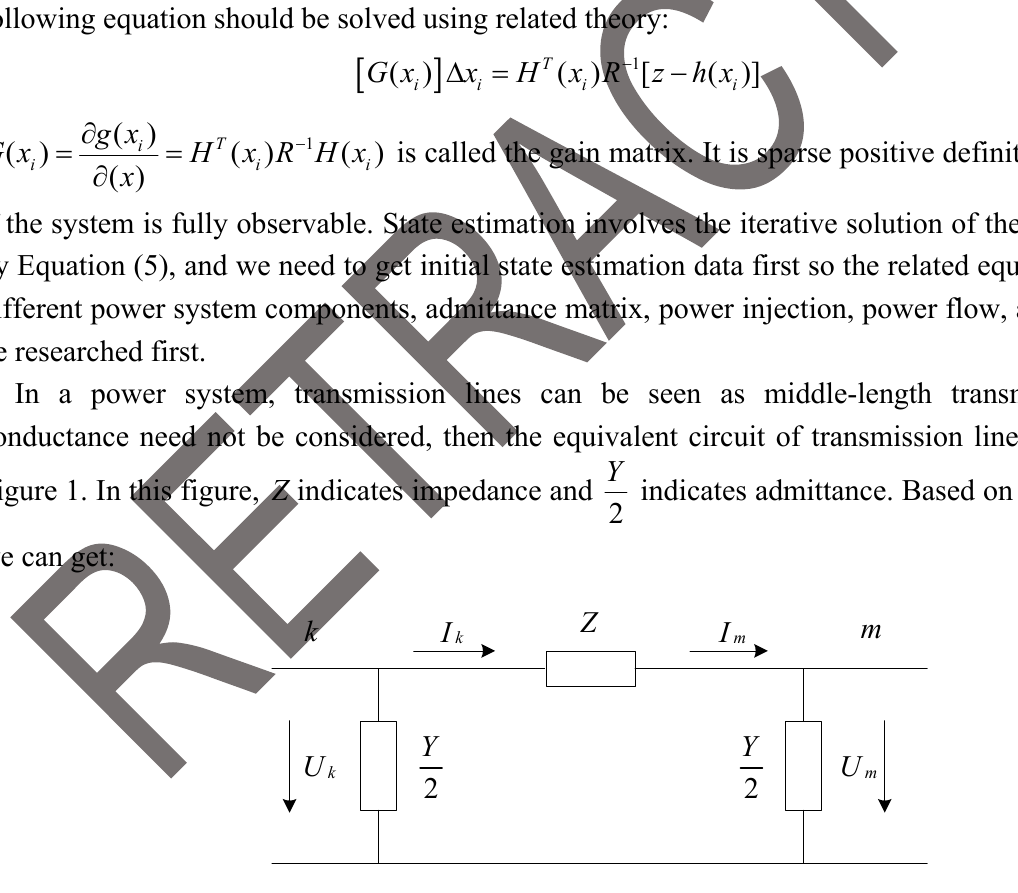
Figure 1. Equivalent circuit for transmission